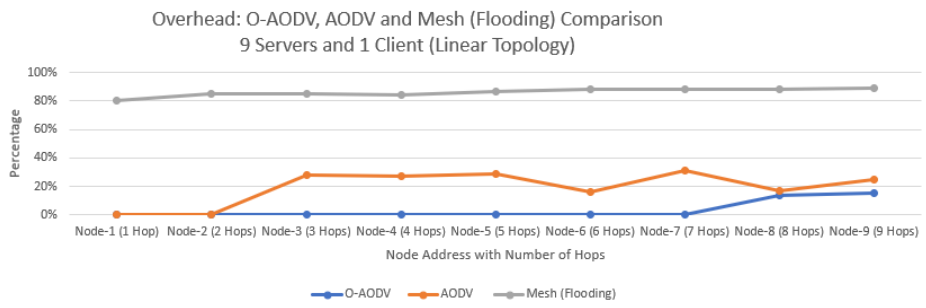
Figure 10. Overhead: O-AODV, AODV, and mesh (flooding) comparison.